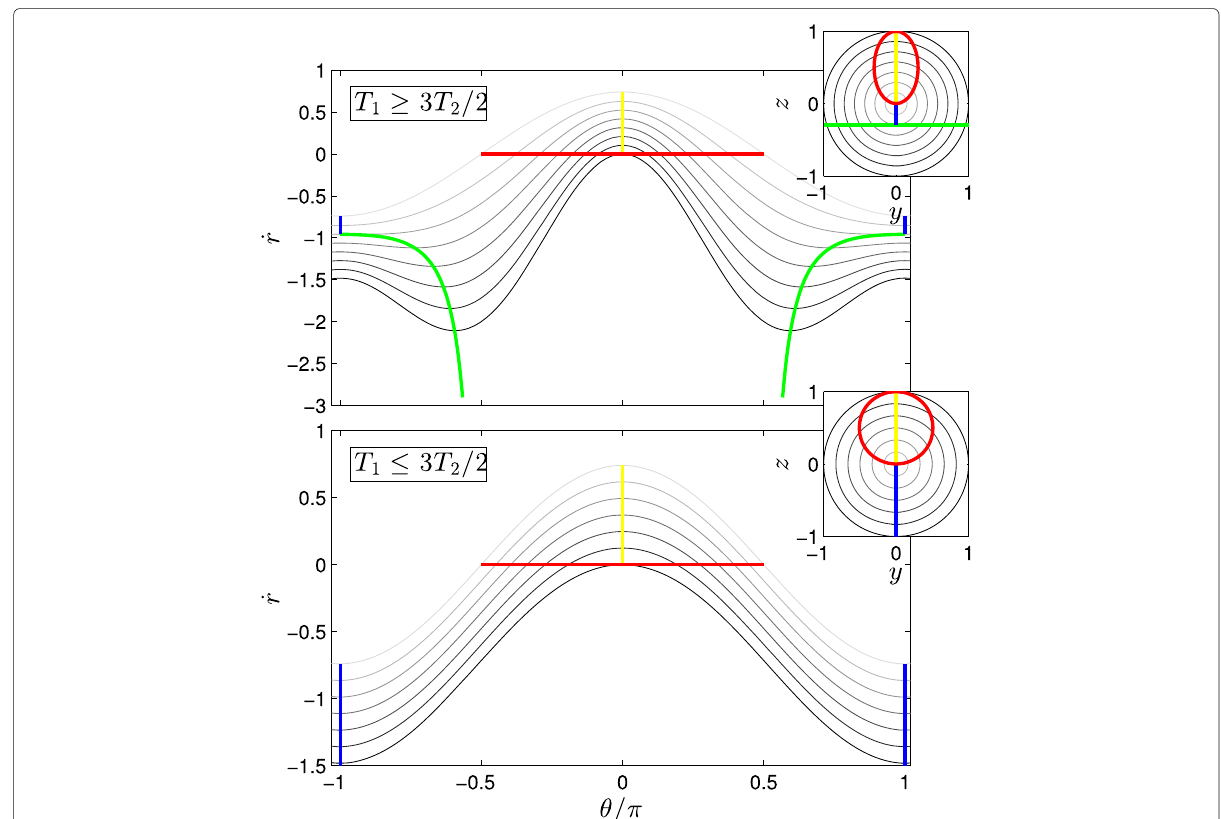
Fig. 2 (Color online) Contour plot of the trajectories ˙ R (θ) for two different sets of relaxation parameters. The red line is the line for which ˙ R = 0. The blue and green lines are the set of points where ˙ r is minimum, while the points of the yellow one correspond to a maximum. The small inserts display in the ( y , z ) - plane the trace of the corresponding sets of points. Circles of different radii are also plotted to help the